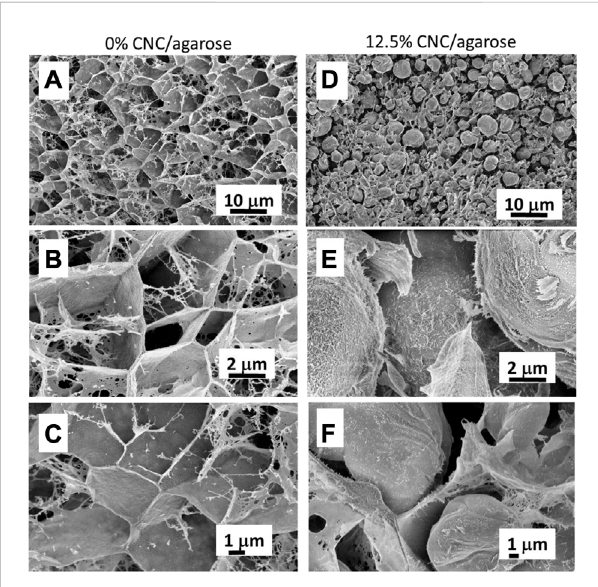
FIGURE 2 CNC/agaroseand agarose gel characterization.